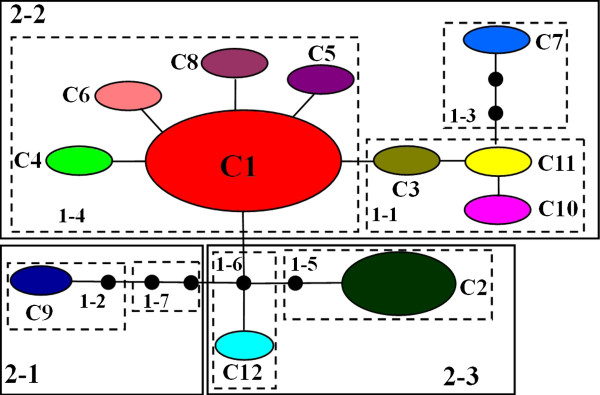
Nested cladogram of 12 chlorotypes across the 21 C. taliensis populations.  Circles in colors denote different haplotypes, and the size of each circle is proportional to that haplotype frequency across populations. Each branch between the haplotypes represents a mutational step. The dotted lines indicate independent mutation events converging on a shared haplotype. The squared loops show the nested clades or haplotypes in the network, which were resolved by nested clade phylogeographic analysis (NCPA).